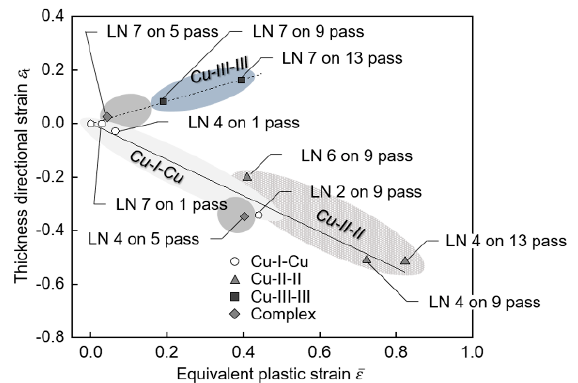
Figure 2. Relationship between the thickness directional and equivalent plastic strains of the spun aluminum disk. Four types of plots: circle, triangle, square, and diamond indicate layer structures characterized by textures: Cu-I-Cu, Cu-II-II, Cu-III-III, and complex types, respectively. The Cu texture was {112} < 111 > . Texture-I rotated 20 ◦ around its < 111 > from the Cu texture. Texture-II rotated 5 ◦ around its < 110 > from the Cu texture. Texture-III rotated 10 ◦ around its < 001 > from texture-I.